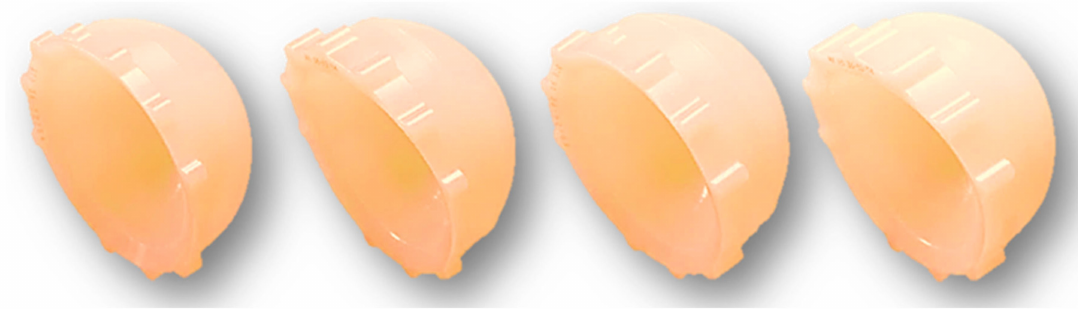
Figure 4. Different acetabular liner model designs with moderately cross-linked UHMWPE